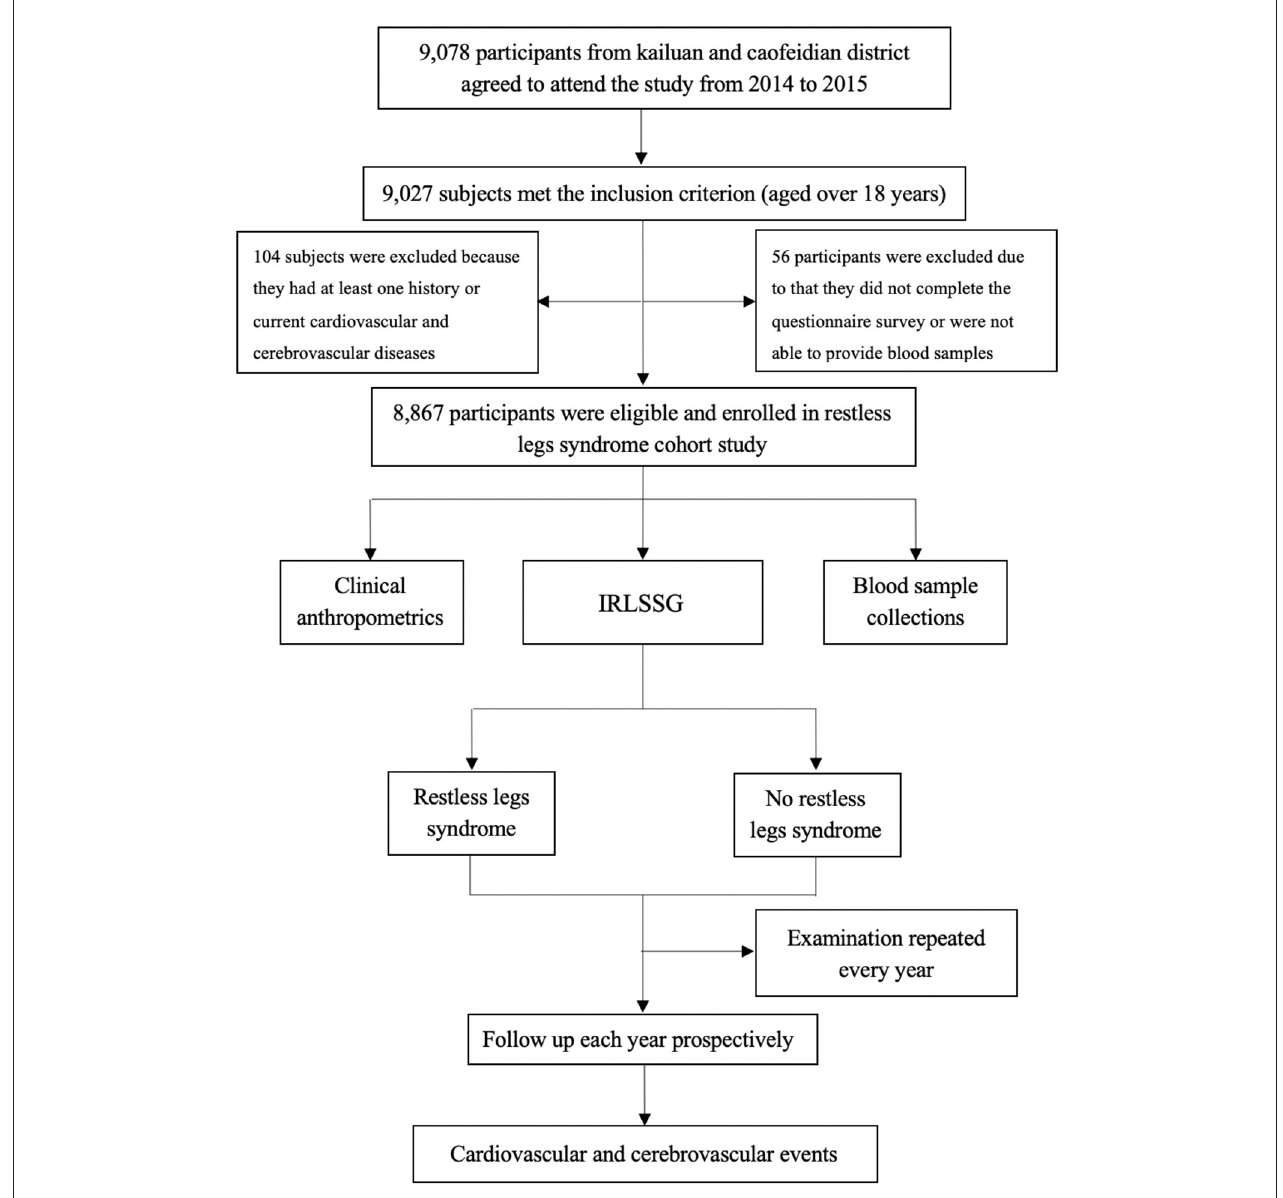
FIGURE 1 | Flow chart of the Jidong Restless Legs Syndrome Cohort Study. IRLSSG, International Restless Legs Syndrome Study